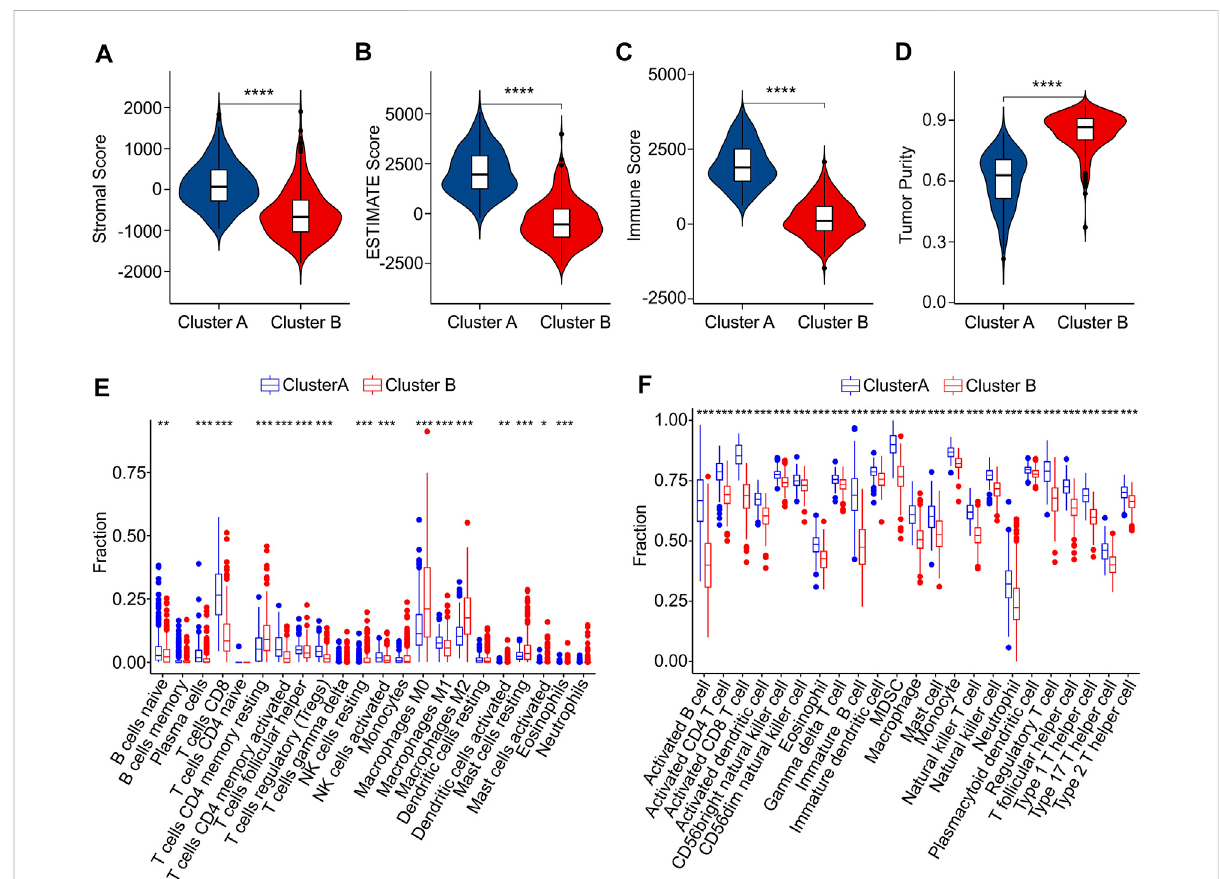
FIGURE 7 Immune in fi ltration landscape analysis of CM patients in Cluster A and Cluster B. (A) Stromal score. (B) ESTIMATE score. (C) Immune score. (D) Tumor purity. (E) The fraction of 22 immune cells in Cluster A and Cluster B calculated by CIBERSORT algorithm. (F) The fraction of 23 immune cells in Cluster A and Cluster B via ssGSEA